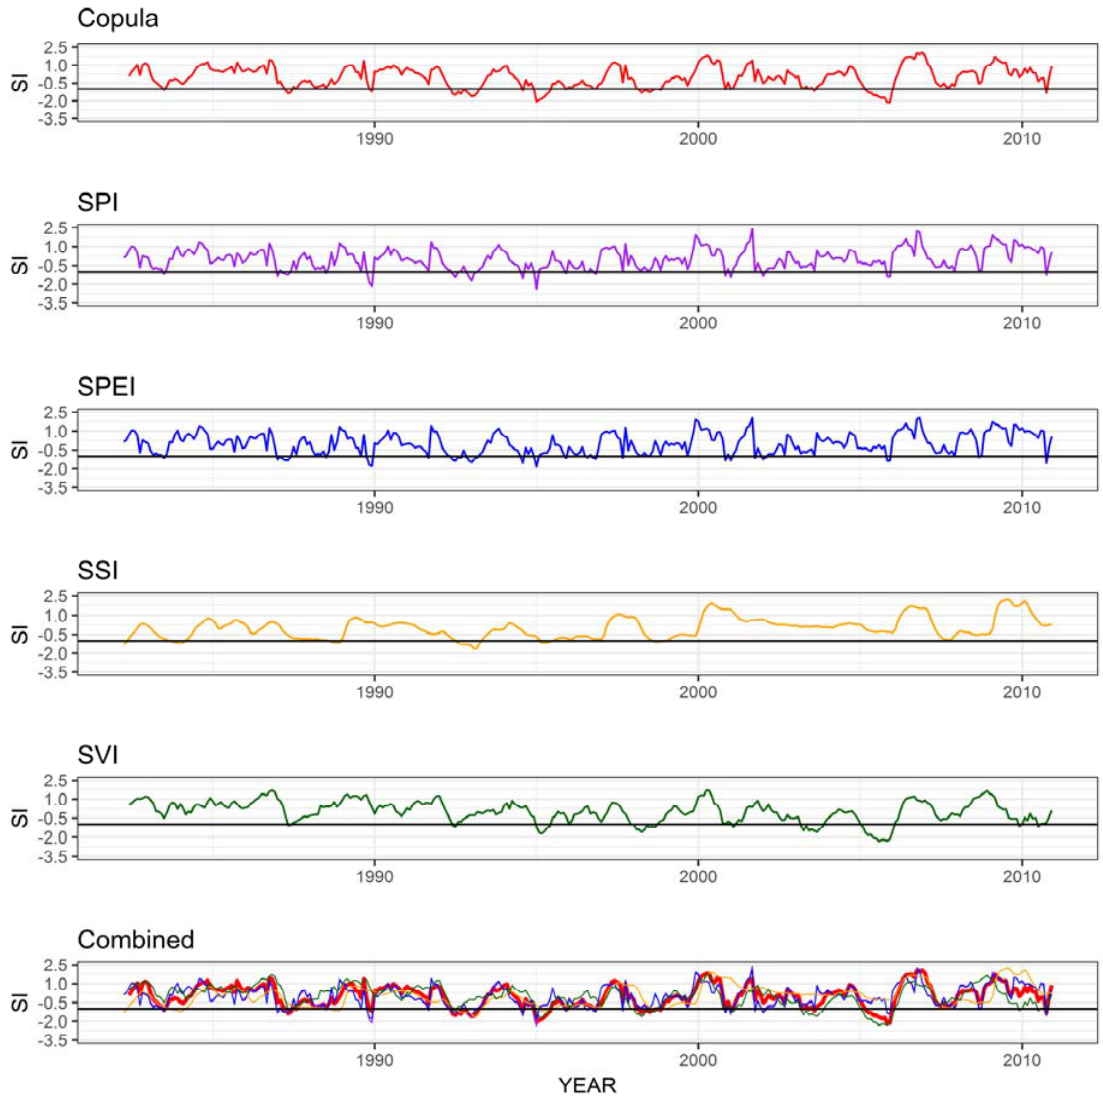
Figure 2. Drought indicators as standardized 6-months running averages of the entire Basin. The solid horizontal line indicates the threshold value of –1. SPI = Standardized Precipitation Index, SPEI = Standardized Precipitation Evapotranspiration Index, SSI = Standardized Soil Moisture Index, SVI = Standardized Vegetation Index.